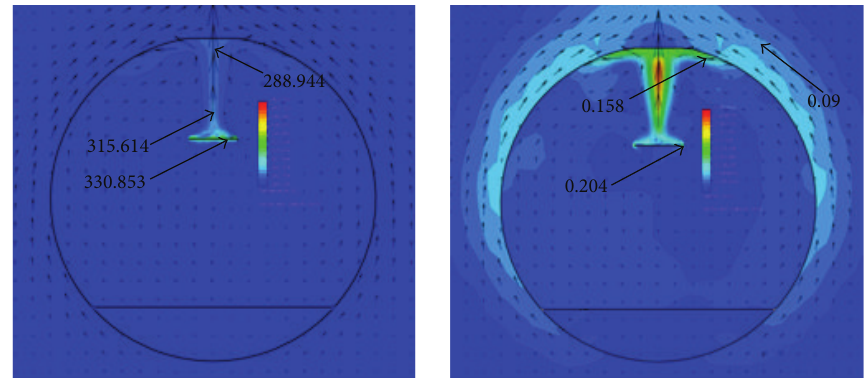
Figure 6: Cross-section temperature and velocity field of the test specimen.